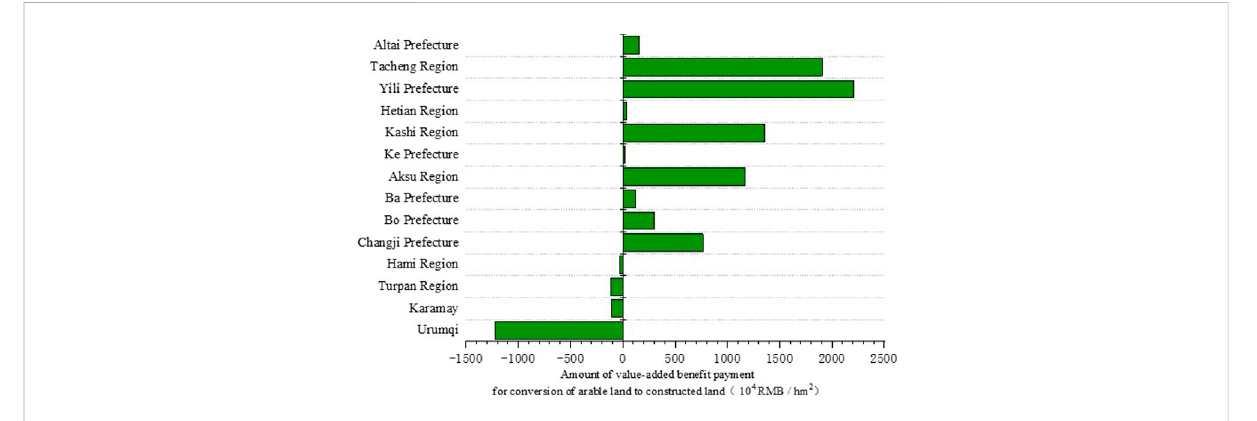
FIGURE 5 Distribution of value-added bene fi t payments for conversion of cultivated land to constructed land in the state